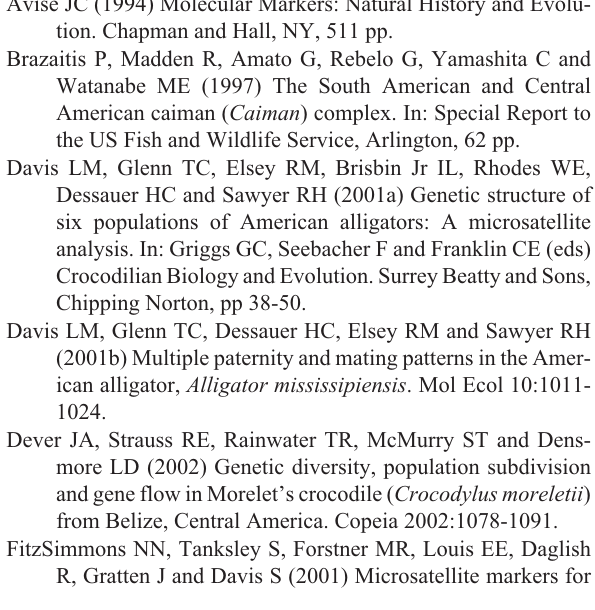
Table 2 - Sample genotypes with alleles size in base pairs. Allele range in Caiman latirostris